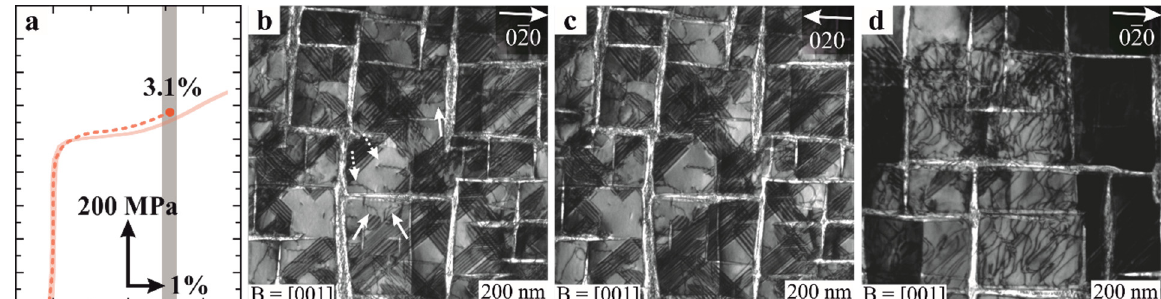
Figure 3. Defect structures in VF60 after a compression test at 950 °C and a strain ‐ rate of 1 ⋅ 10 − 3 s − 1 interrupted at a plastic strain of 3.1%. The interrupted stress ‐ strain curve is shown in ( a ). All TEM micrographs were taken in two ‐ beam conditions close to the [001] zone axis and with ( b , d ) g = 0–20 (BF) and ( c ) g = 020 (CDF).